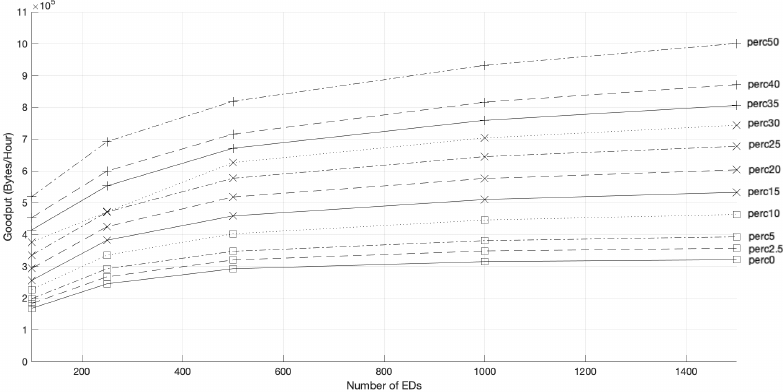
Figure 15. Network goodput for 3 GWs, different network sizes and different